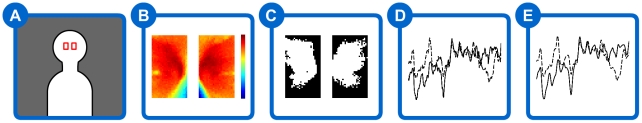
Mean temperature time series extraction procedure.
A: The left and right periorbital regions are tracked from an initial reference frame to the end of the trial. B: The result of the tracking process is a pair of thermal videos, each showing one of the two periorbital regions (shown here with false colouring). C: For each frame of each periorbital's video, the temperature pixels are sorted from coolest to warmest and the warmest 50% of the pixels are identified. Note that the majority of the pixels on the border of the tracking region are not in the warmest 50%. D: For each frame, the mean of the 50% warmest pixels is taken for each periorbital region to generate a mean temperature time series for each periorbital region. E: The mean temperature time series is low-pass filtered to remove residual noise due to minor tracking fluctuations and thermal camera noise.